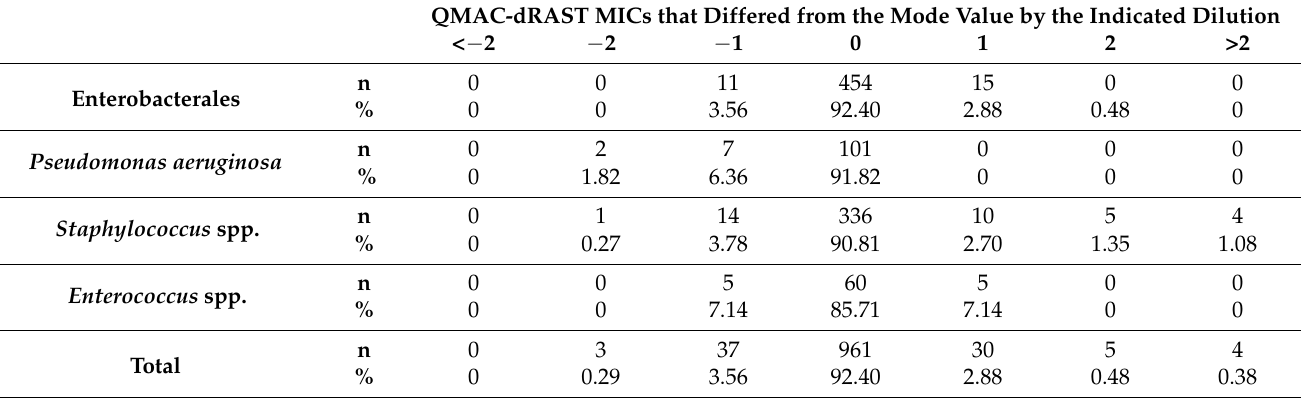
Table 3. Repeatability results obtained with the QMAC-dRAST.